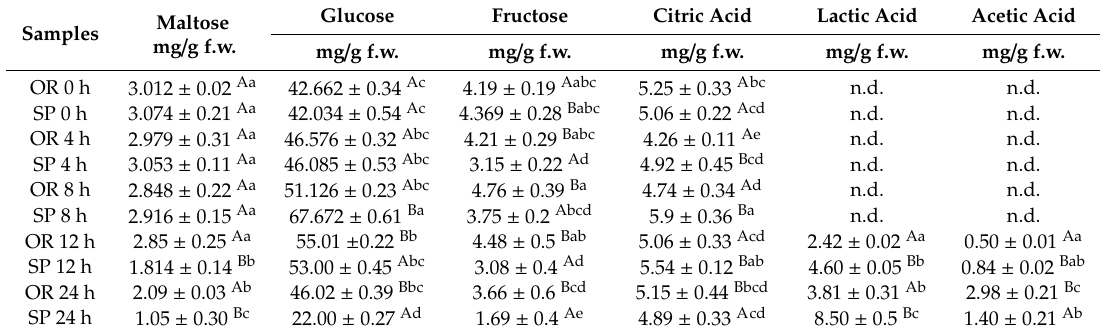
Table 3. OR and SP carbohydrates and organic acids content during 24 h of fermentation. Maltose Samples mg / g f.w.